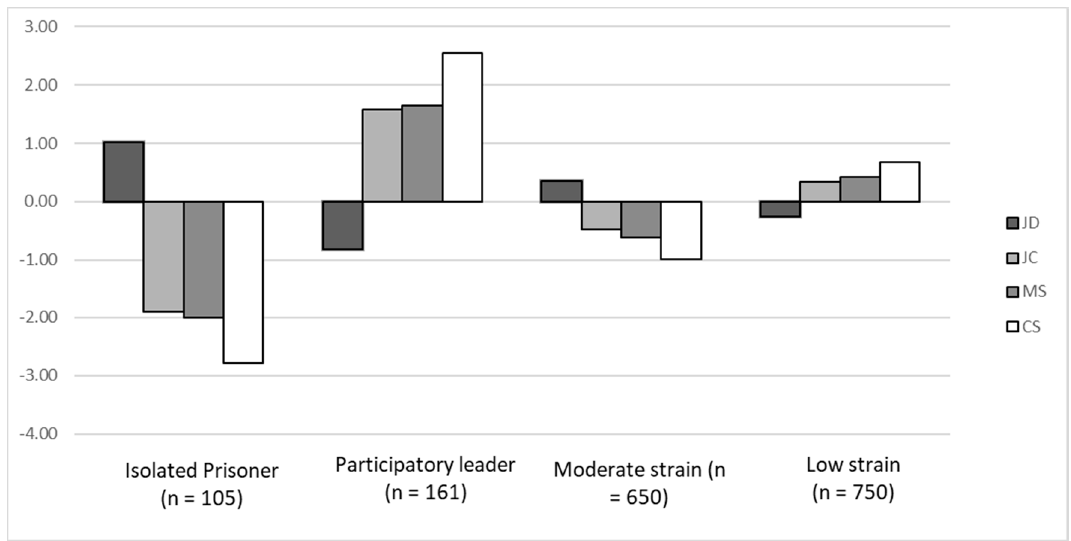
Figure 3. Results from the Latent Profiles Models (standardized values). JD = Job demands; JC = Job Control; MS = Managerial Support; CS = Coworkers’ Support.